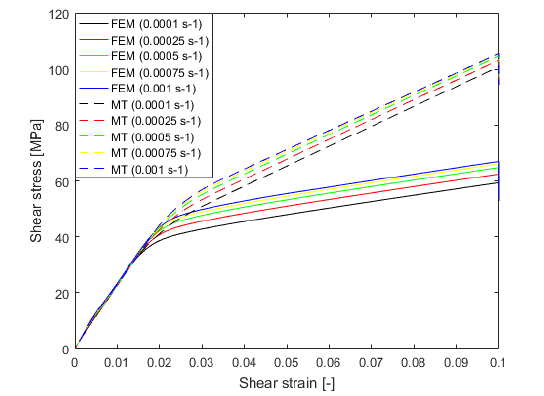
Figure 8. Stress-strain diagrams for various uniaxial tensile strain rate loading.